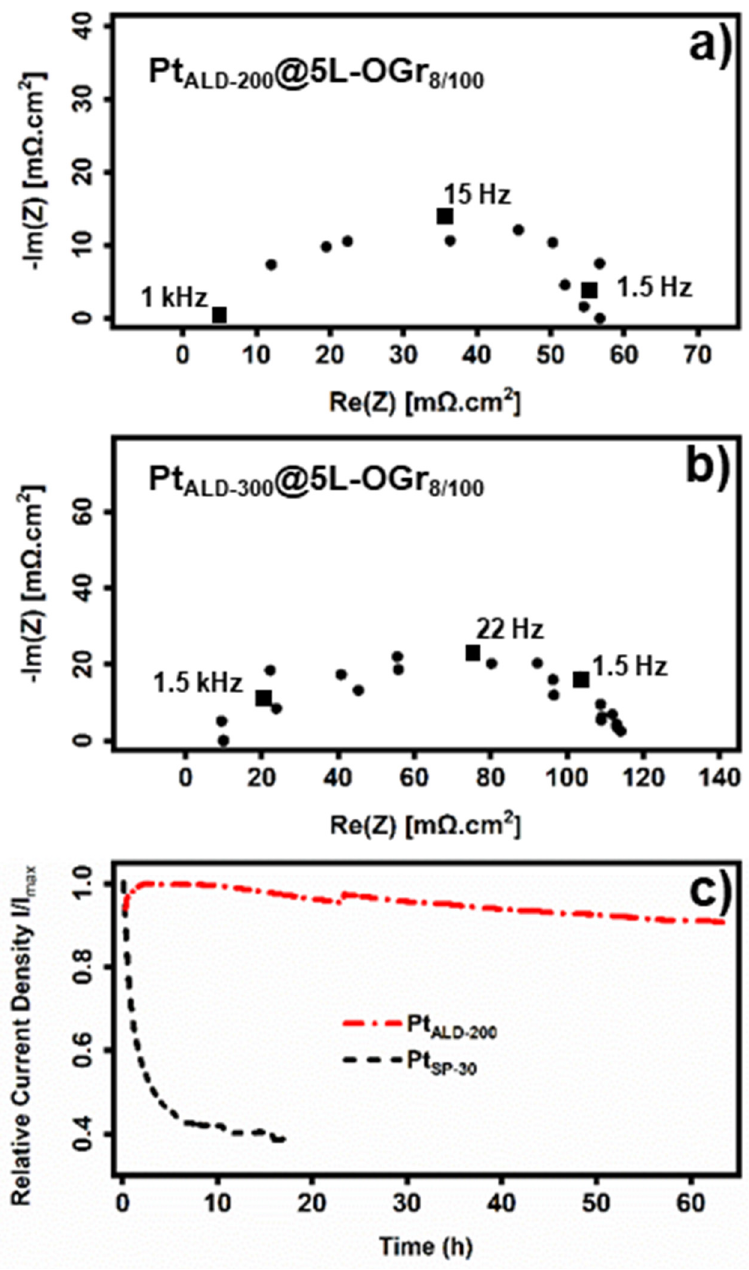
Figure 5. Nyquist Plot of the electrode impedance of the Pt ALD @5L-OGr 8/100 samples measured under anode conditions after ( a ) 200 and ( b ) 300 ALD cycles. The electrolyte resistance was subtracted in both cases. ( c ) The current density of the Pt ALD-200 @5L-OGr 8/100 sample (dashed–dotted line) over 60 h was measured at 0.35V under fuel cell conditions. The electrodes based on 30 nm Pt films sputtered directly on the CsH 2 PO 4 pellets are included for comparison (dashed line) in ( c ). All the platinum-decorated oxidized graphene samples were transferred using PMMA and iron chloride in hydrochloric acid as an etchant. The open-circuit voltage was 0.88 V for the Pt ALD-200 @5L-OGr 8/100 sample and 0.86 V for the Pt SP-30 sample.